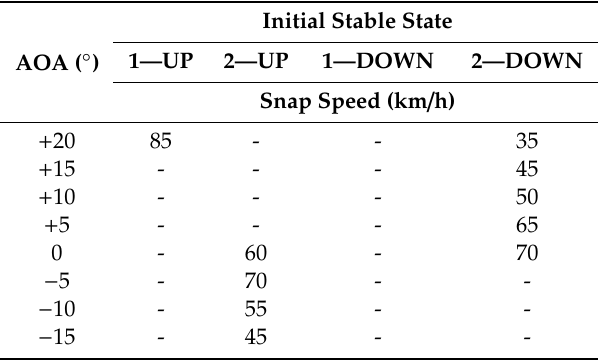
Table 4. Experimental wind tunnel